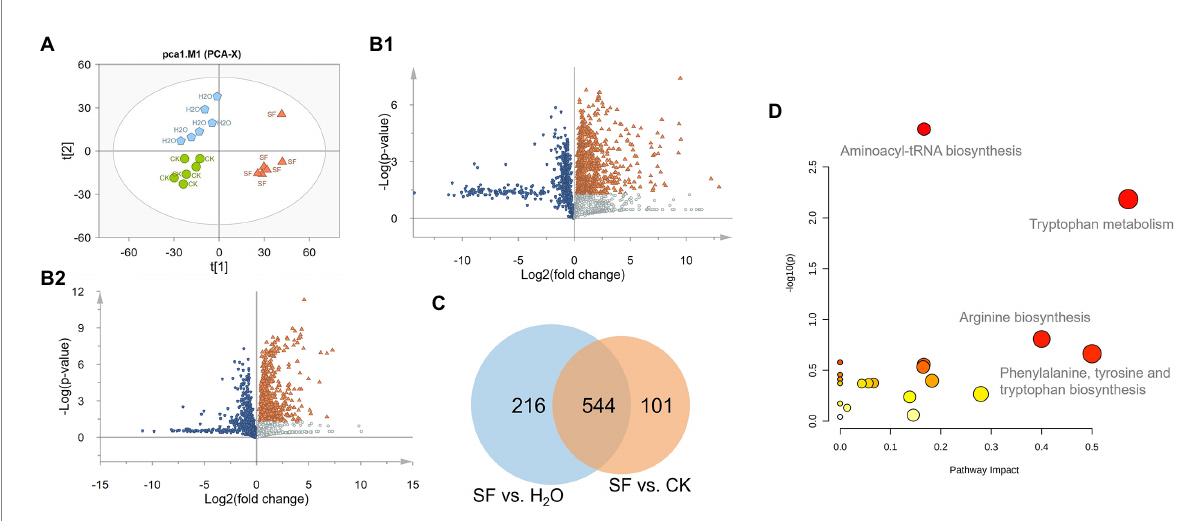
FIGURE 2 Statistical analysis of the normalized dataset: (A) PCA score plot of the 3 treatments. Green indicates CK, blue indicates H 2 O, and orange indicates SF; (B) Volcano plots of SF vs. CK and SF vs. H 2 O. Blue represents downregulation, orange represents significant upregulation, and silver represents upregulation but no significant difference. (C) Venn diagram of significantly differentially abundant compounds. (D) Results of pathway analysis. The pathway impact value was calculated by pathway topology